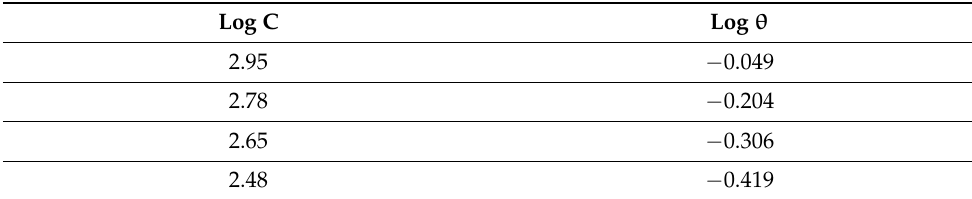
Table 8. (c/θ), (θ) , and c values as determined from Table 5.